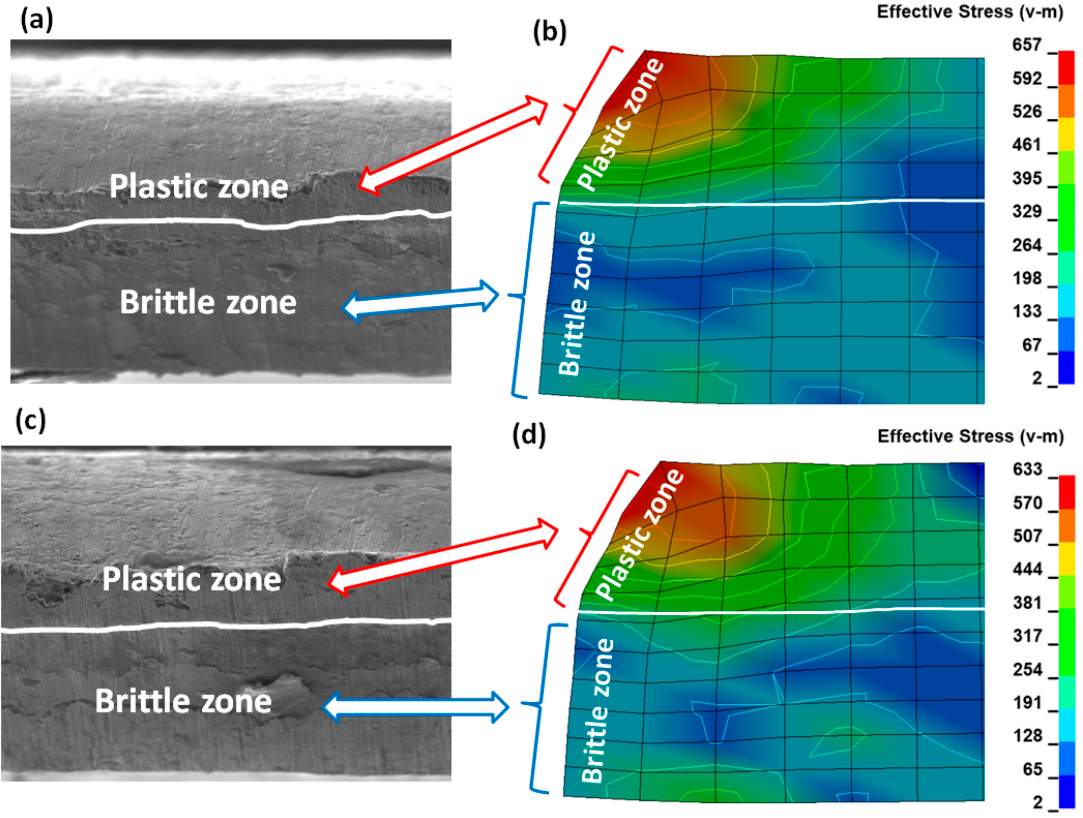
Figure 10. Comparison of the experimental and numerical results.